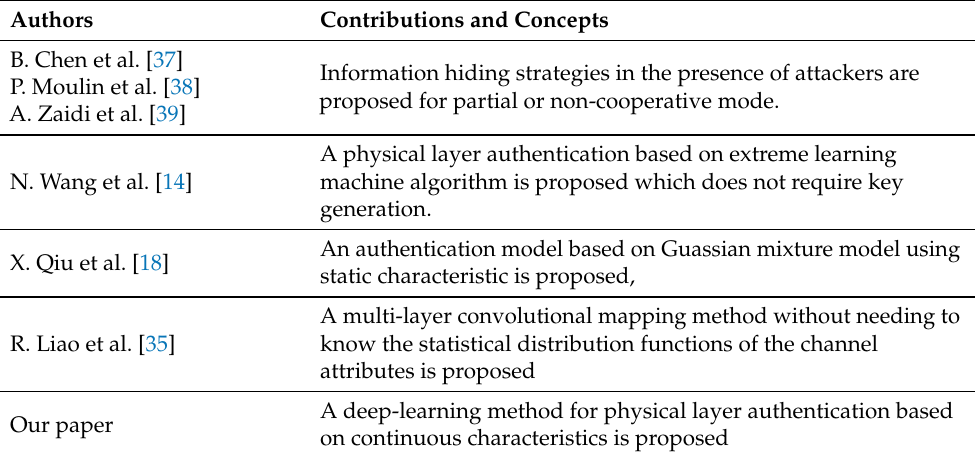
Table 1. Different security authentication